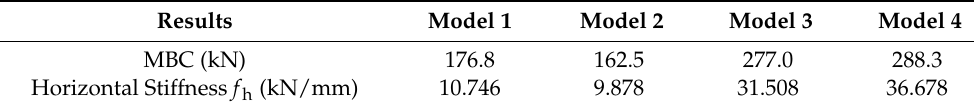
Figure 10. Relationships between horizontal load F 1 and displacements D h in top arch. Table 2. Maximum bearing capacities (MBC) and horizontal stiffness in top arch. Results